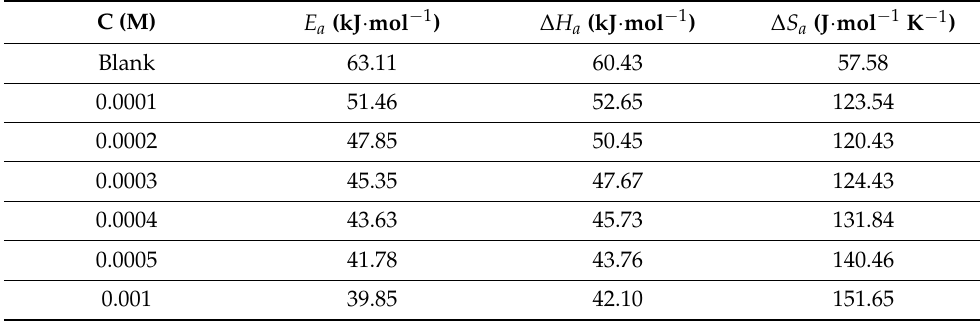
Figure 5. A plot of Arrhenius modified equations of log concentrations of the examined inhibitor. Table 2. Isothermal parameter values for mild-steel coupon in 1 M HCl in the absence and presence of different concentrations of PMBMH.